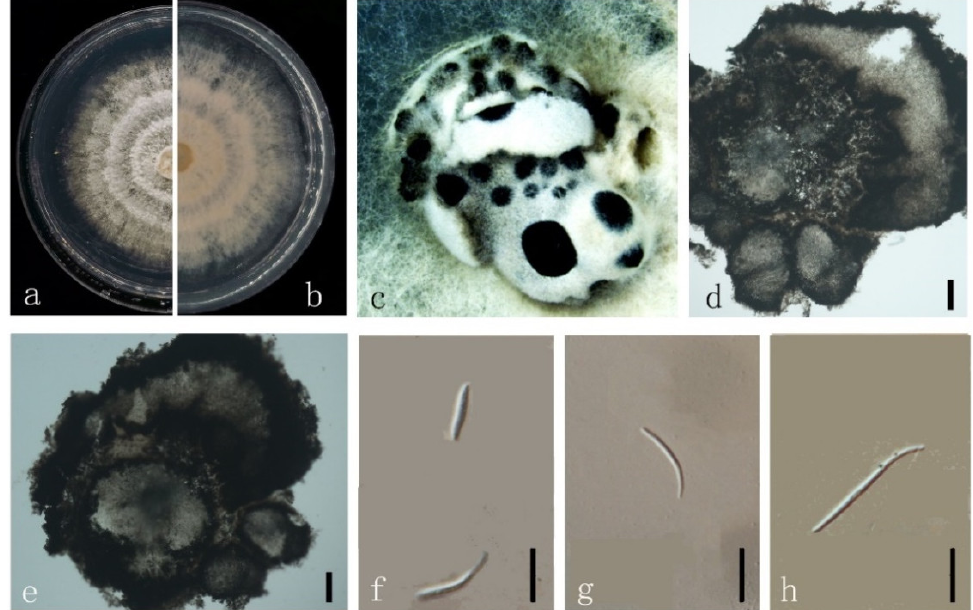
Figure 6. Diaporthe guangxiensis (ZHKUCC 22-0046) ( a ) upper view of colonies on PDA; ( b ) Reverse view of colonies on PDA; ( c ) Pycnidia with conidial droplets on PDA; ( d , e ) cross section of pycnidia; ( f – h ) Beta conidia; Scale bars: ( d , e ) =100 µm; ( f – h ) =10 µm.